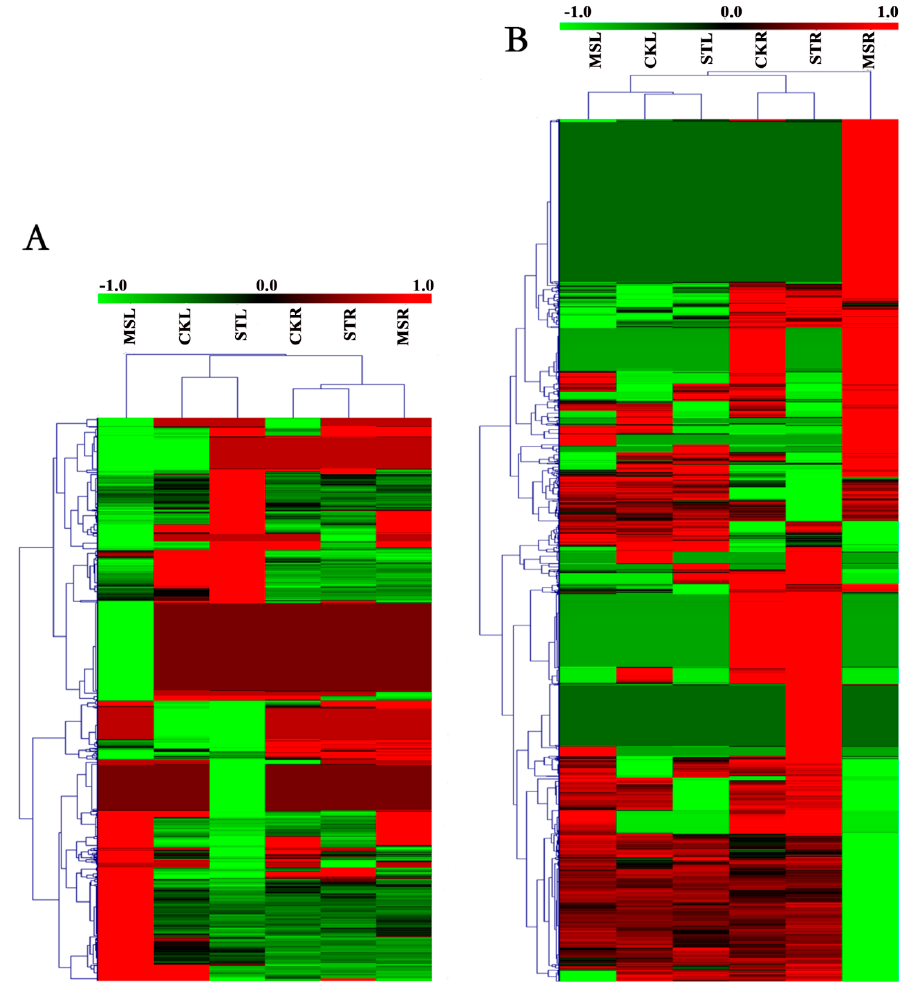
Figure 4. Heat map showing the expression mode and strength of the di ff erentially expressed genes (DEGs) in the di ff erent samples. Expression values from RNA-seq data were log 2 -transformed and are displayed as filled blocks colored green to red. ( A ) Expression profiles under di ff erent treatments of the DEGs from the MSL versus STL comparison. ( B ) Expression profiles under di ff erent treatments of the DEGs from the MSR versus STR comparison.